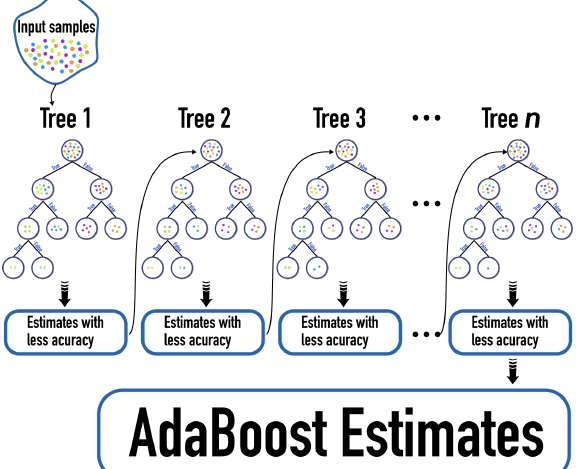
Figure 3. Ada Boost diagram.